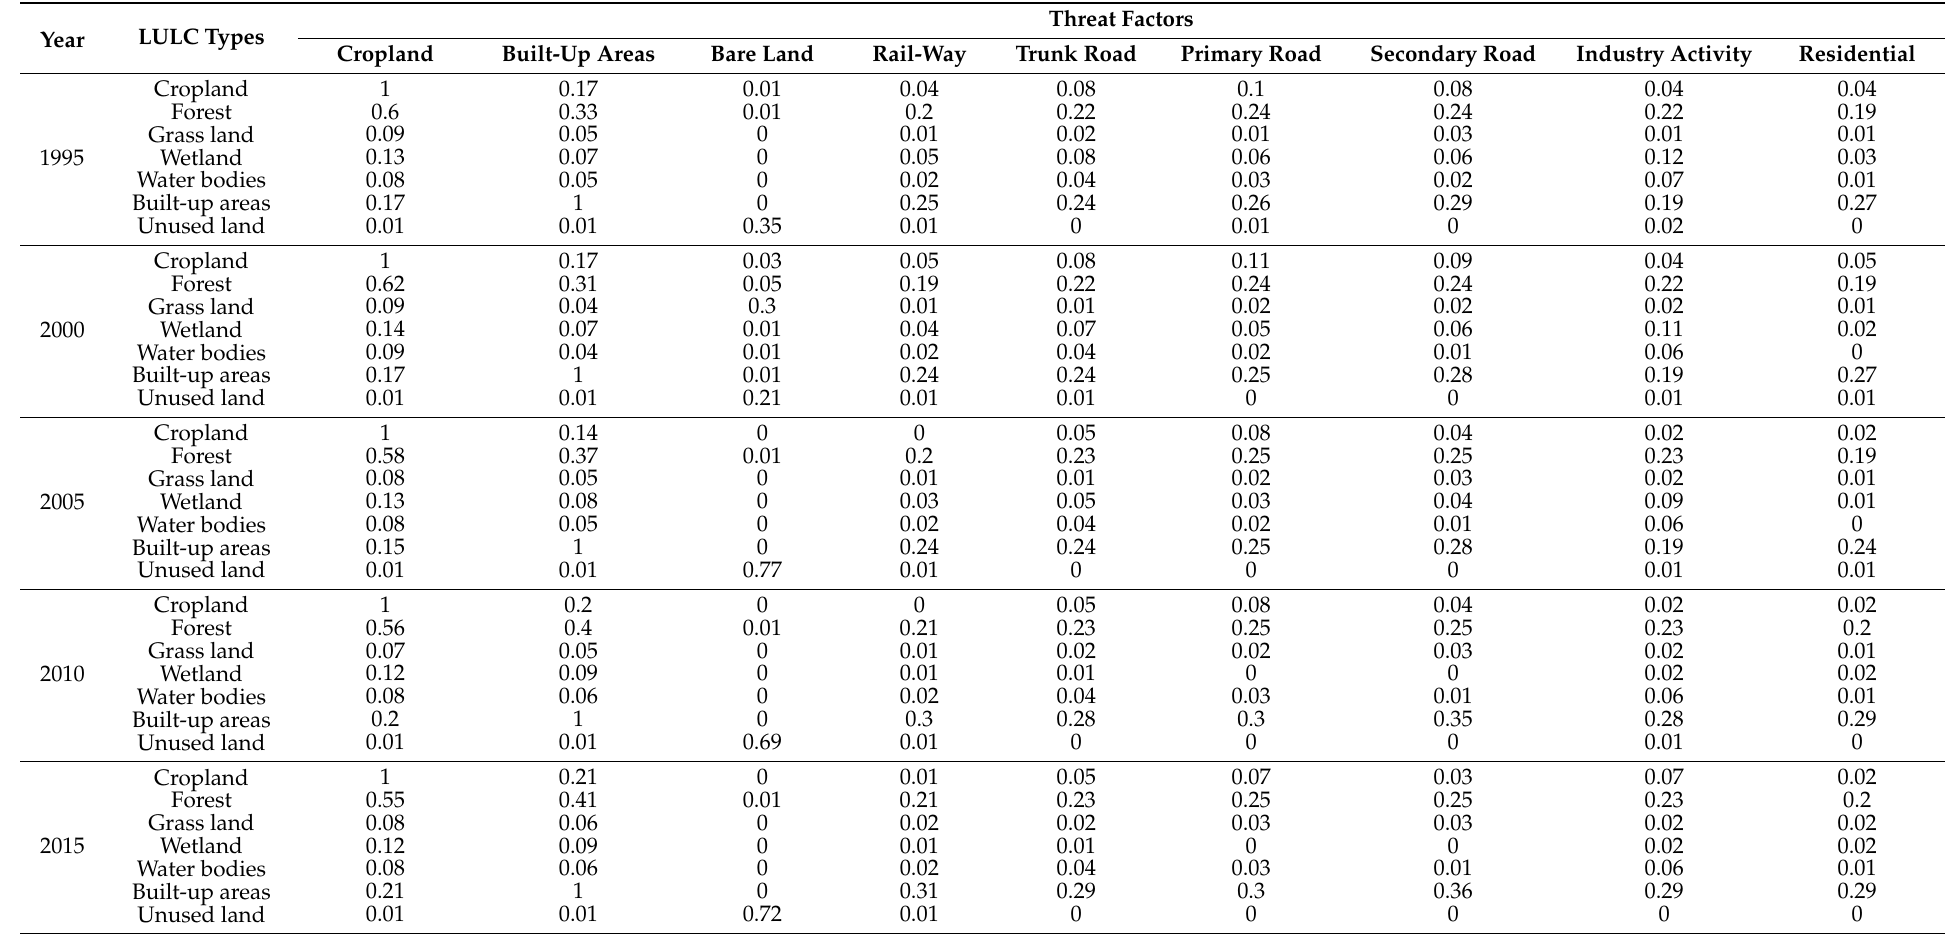
Table A1. The sensitivity score of habitat types to threat